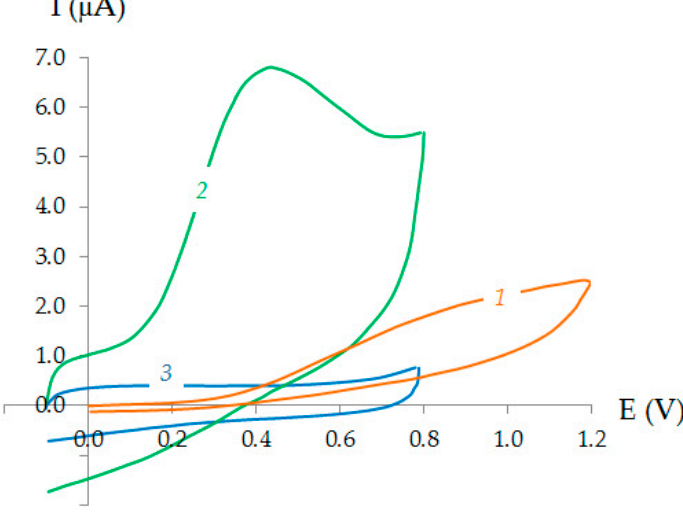
Figure 1. Cyclic voltammograms on CVE ( 1 ) and Au-gr / CVE ( 2 , 3 ) in the PBS, pH 7, without ( 3 ) and in the presence of 0.1 mM AA ( 1 , 2 ). ν = 0.05 Vs − 1 .